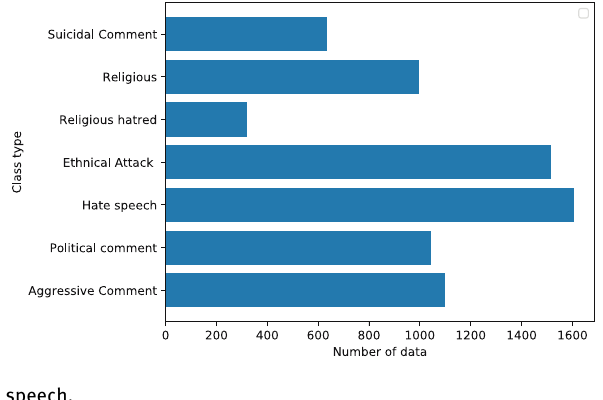
Figure 2: Categories of hate speech.